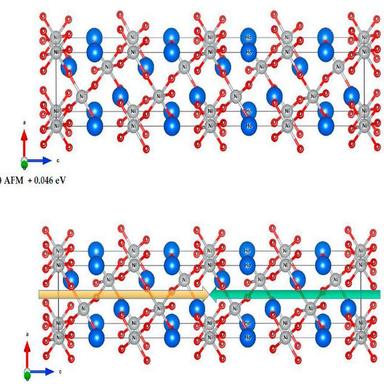
Total energies of the FM, NM, and AFM states of rhombohedral R3c-type HoNiO3 with a 1 � 1 � 2 superlattice.